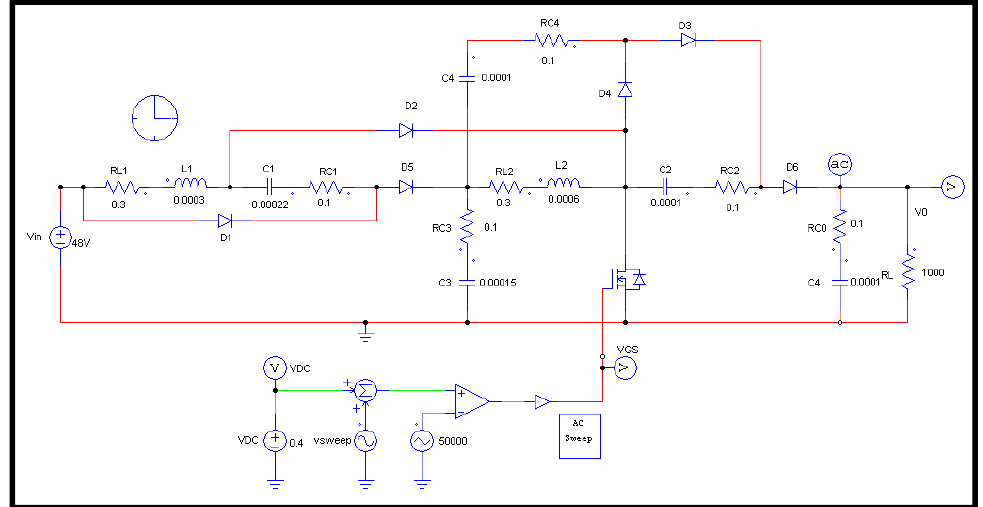
Figure 26. Circuit configuration simulated in PSIM for small signal analysis.